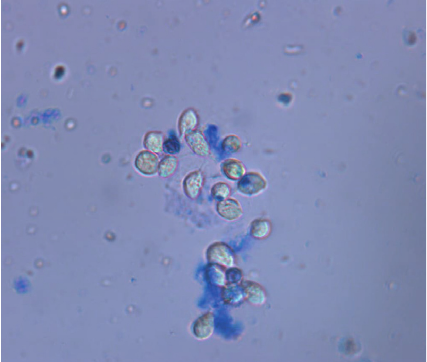
Figure 8: Microscopic image of the trichomonacidal activity of dye II against T. vaginalis trophozoites after 48